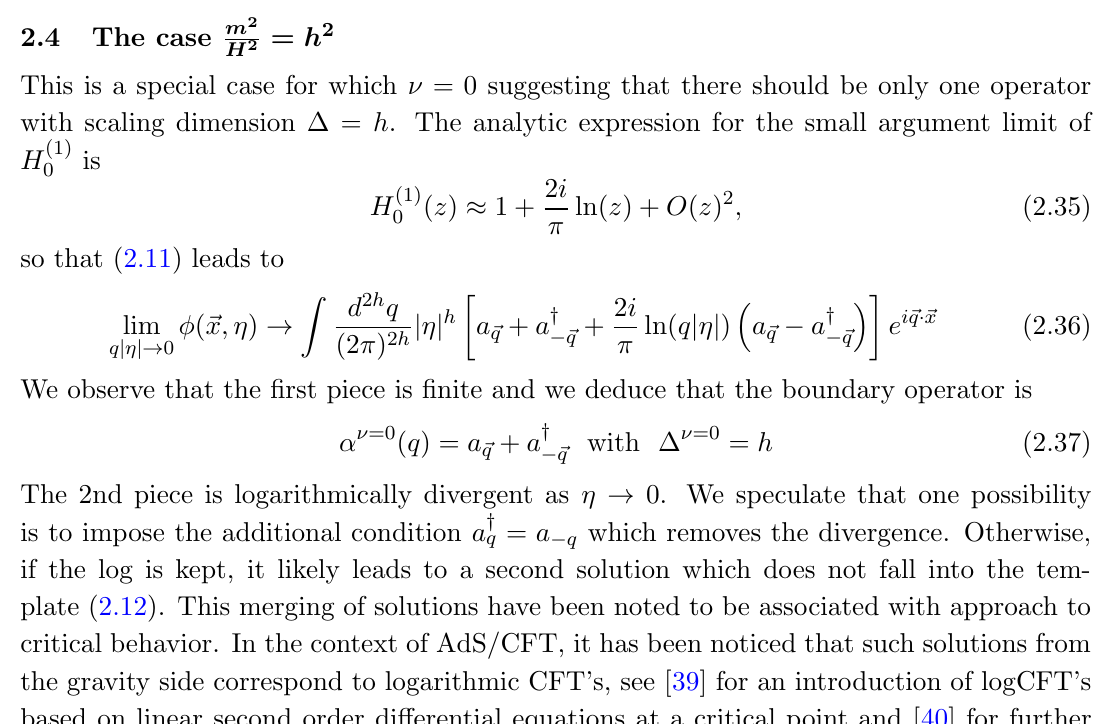
Figure 1 . The shadow transformation takes the branch 2 light (cid:12)eld solutions to the branch 1